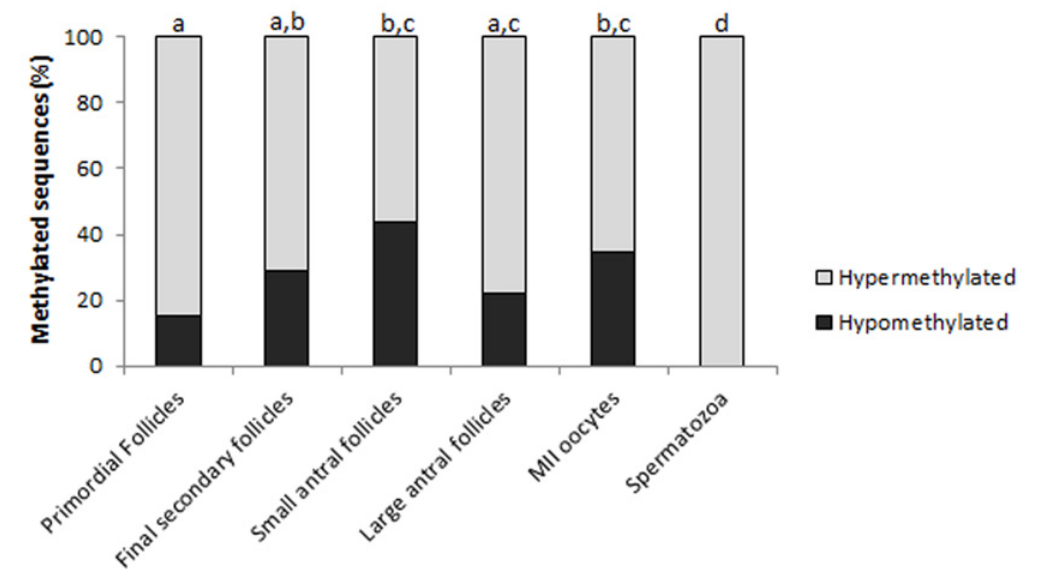
Fig 3. Frequency of IGF2 hypermethylated and hypomethylated alleles. Each bar represents a treatment group that was analyzed (oocytes from primordial, final secondary, small antral and large antral follicles, MII oocytes and spermatozoa). The black part of the bar represents the frequency or proportion of hypomethylated alleles and gray represents the hypermethylated alleles. Different letters represent significant differences between the groups according to the χ 2 test ( p (cid:3)